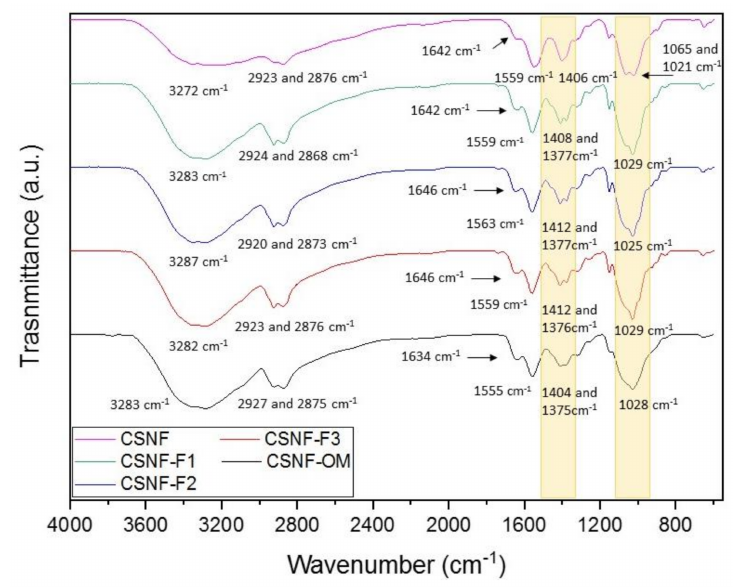
Figure 3. ATR-FTIR spectra of the nanocomposite films.